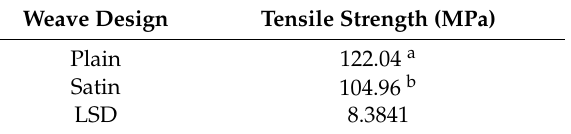
Table 6. Effect of kenaf weave design on the tensile strength of woven kenaf/carbon fibre hybrid composite.